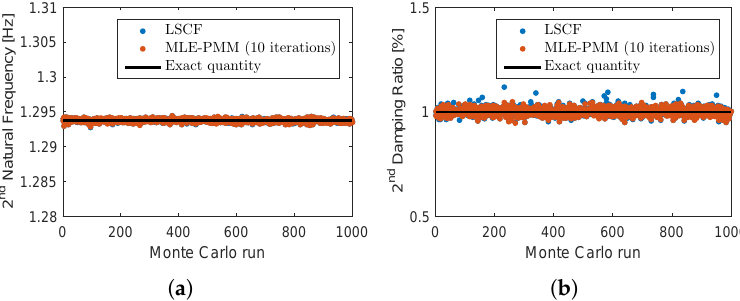
Figure 16. Monte Carlo simulation results for the 2nd identified natural frequency ( a ) and damping ratio ( b ): exact quantity (solid black line), LSCF estimates (blue dots) and MLE-PMM estimates after 20 iterations (red